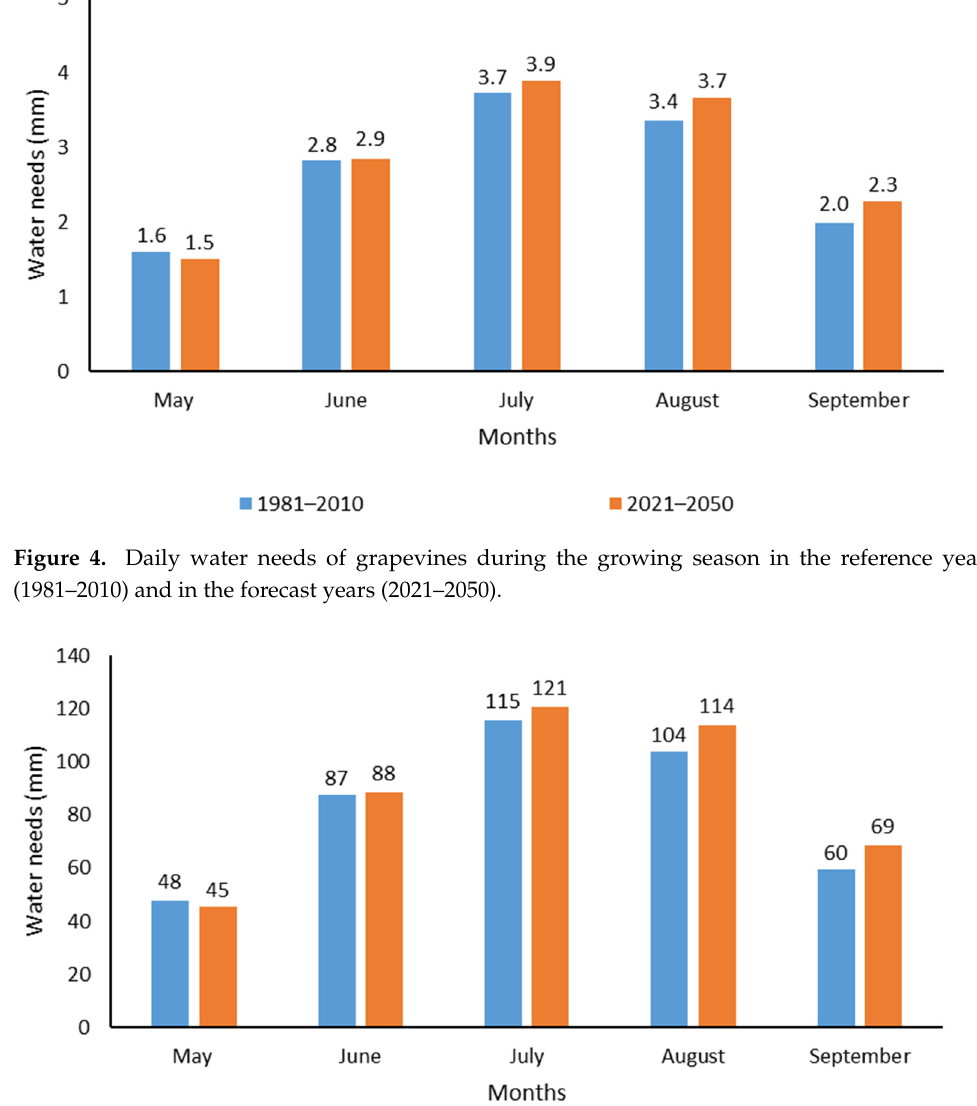
Figure 6. Cumulative sums of grapevines’ water needs during the growing season (May–Septem- ber) in the reference years (1981–2010) and in the forecast years (2021–2050).